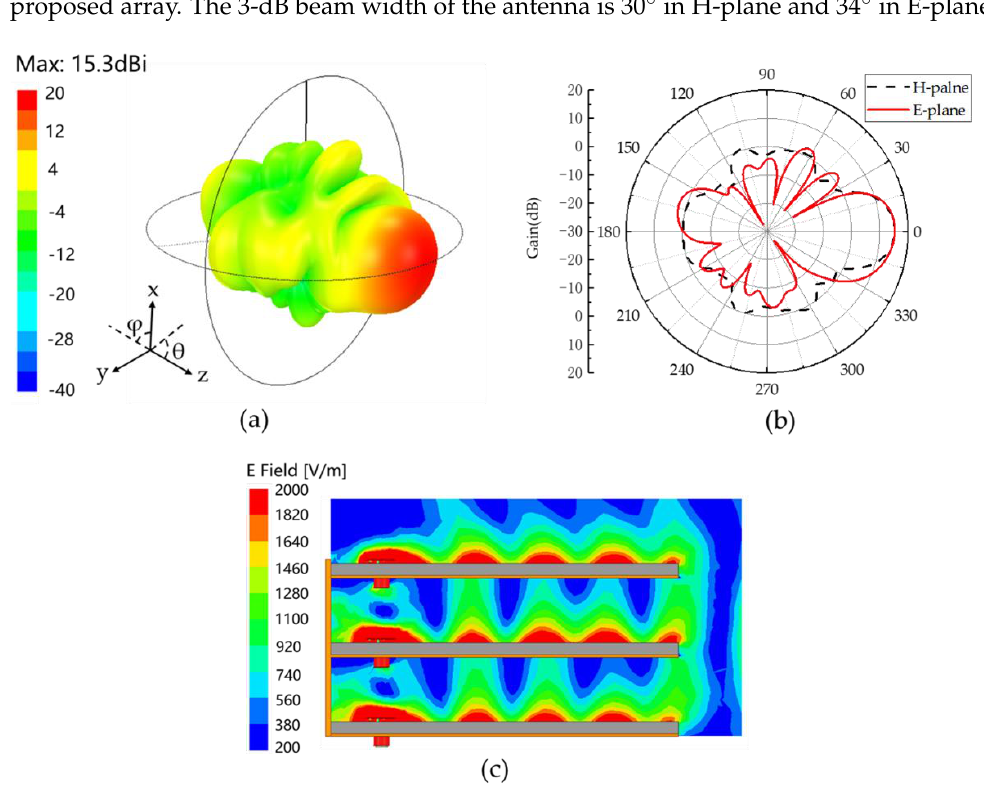
Table 2. Comparison of two dimension aperture efficiency between the proposed array with other aperture antennas.